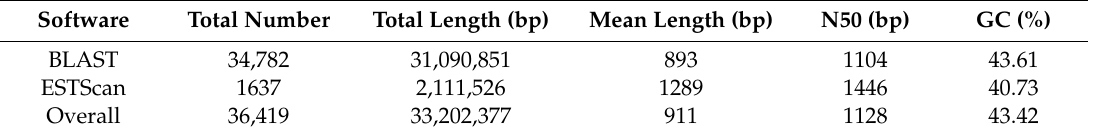
Table 5. Quality metrics of predicted coding DNA sequence (CDS).